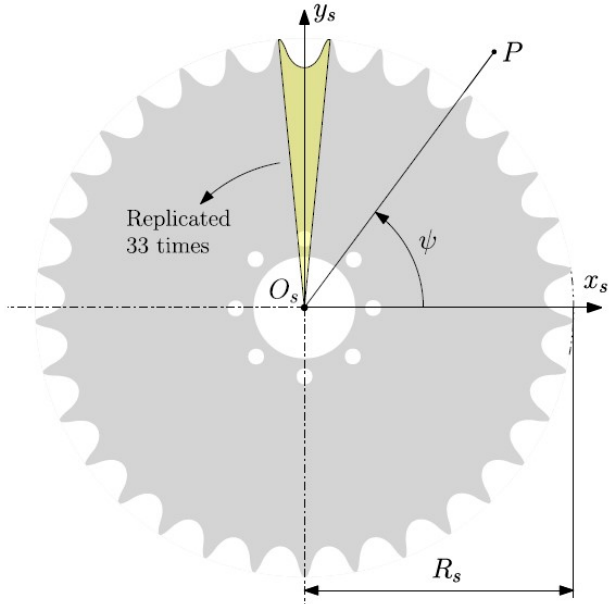
Figure 13. Sprocket gear.